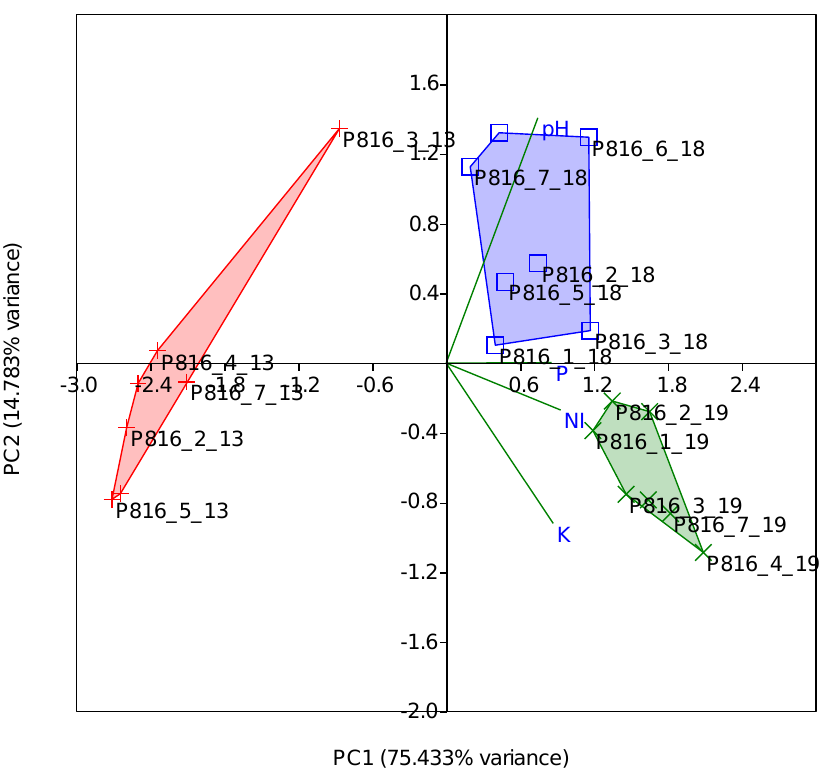
Figure 4. PCA (correlation) diagram, pasture plot P816, Ciacova, Timiș County, Romania, 2013– 2019 period.